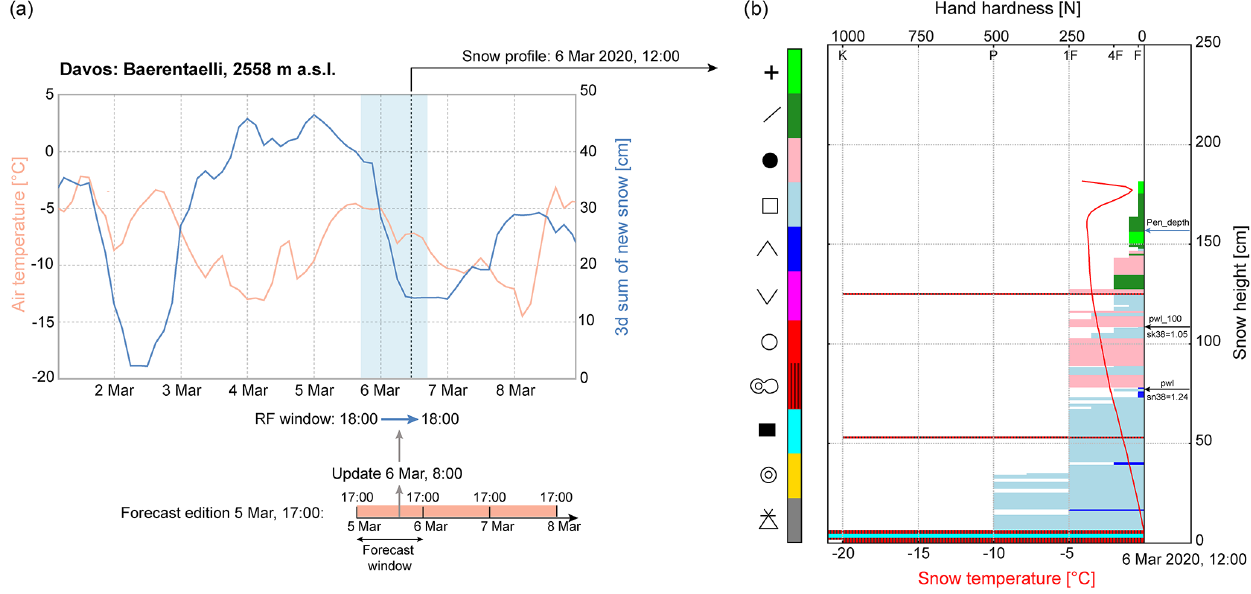
Figure 4. (a) A 7d time series (March 2020) of two meteorological features: air temperature (measured) and 3d sum of new snow height (simulated by SNOWPACK) at the IMIS snow station Baerentaelli, which is located near Davos at 2558ma.s.l. The blue area delimits an example of a 24h time window (random forest, RF, window) from 5 March 2020 at 18:00LT to 6 March 2020 at 18:00LT, which is used to extract the averaged values used as inputs for the random forest algorithm. The avalanche forecast updated on 6 March 2020 at 08:00LT is used for labelling the danger rating over the entire RF window. (b) Simulated snow stratigraphy from SNOWPACK at the same station on 6 March 2020 at 12:00LT showing hand hardness, snow temperature, and grain type (colours). Hand hardness index F corresponds to fist, 4F to four fingers, 1F to one finger, P to pencil, and K to knife. Labels of grain types and colours are coded following the international snow classification (Fierz et al., 2009). The black arrows indicate the two critical weak layers located in the first 100cm of the snow surface (PWL_100) and in a deeper layer (PWL), which were detected with the threshold sum approach. The blue arrow indicates the skier penetration depth